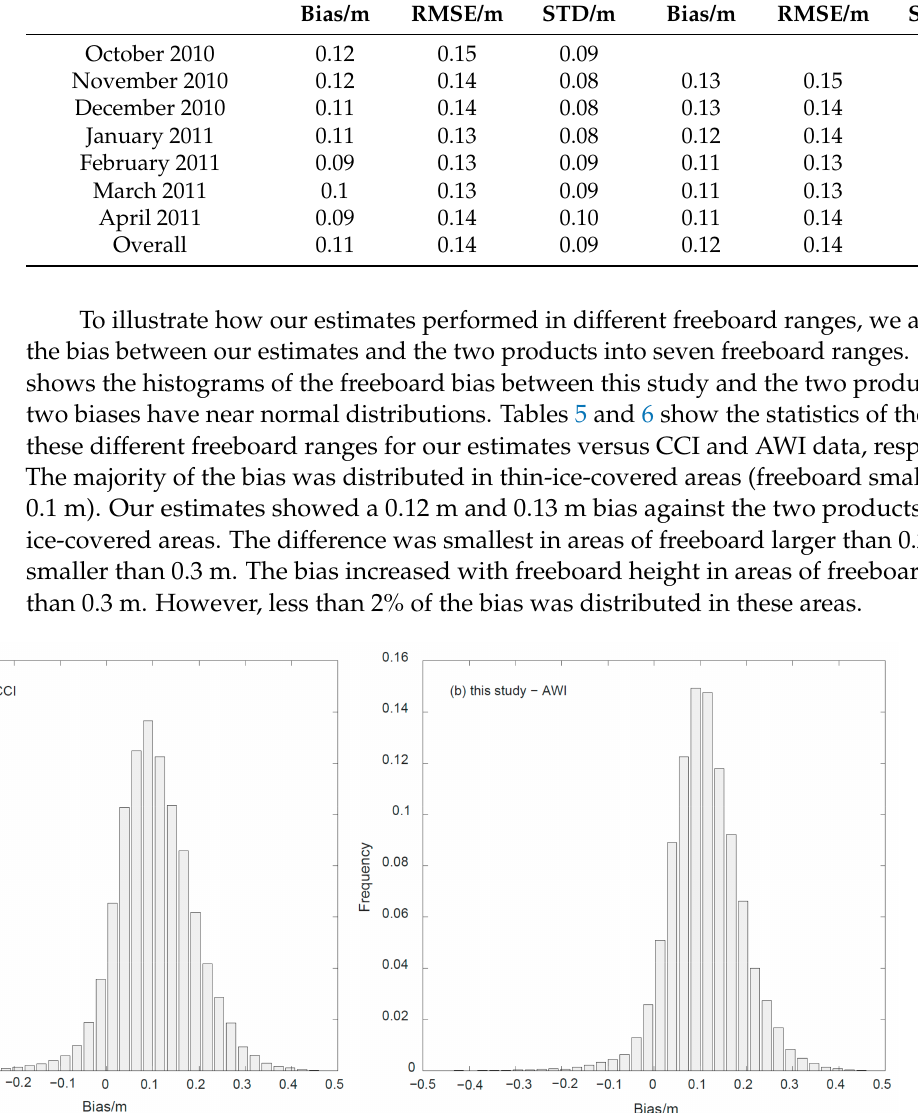
Table 4. Bias between the sea ice freeboards retrieved in this study and that from CCI and AWI. This Study–CCI This Study–AWI Month Bias/m